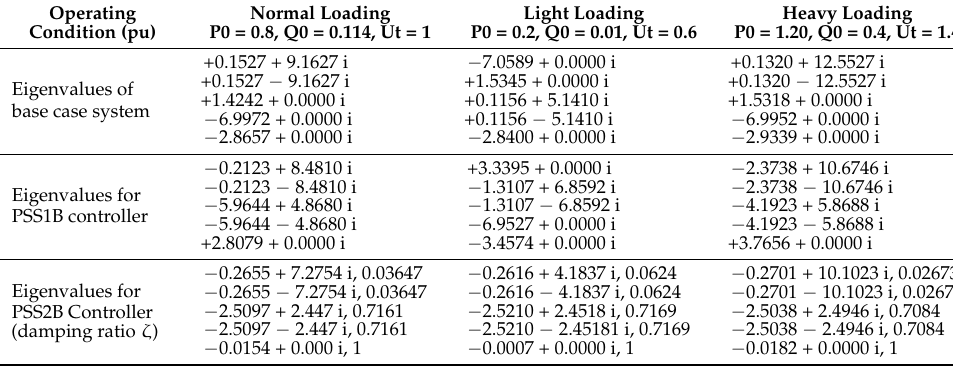
Table 8. Eigenvalues and minimum damping ratios of different loading conditions.